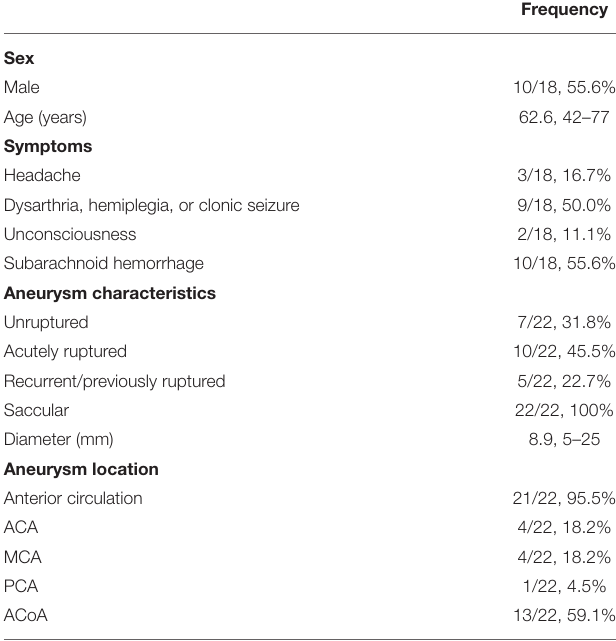
TABLE 1 | Patient demographics and baseline